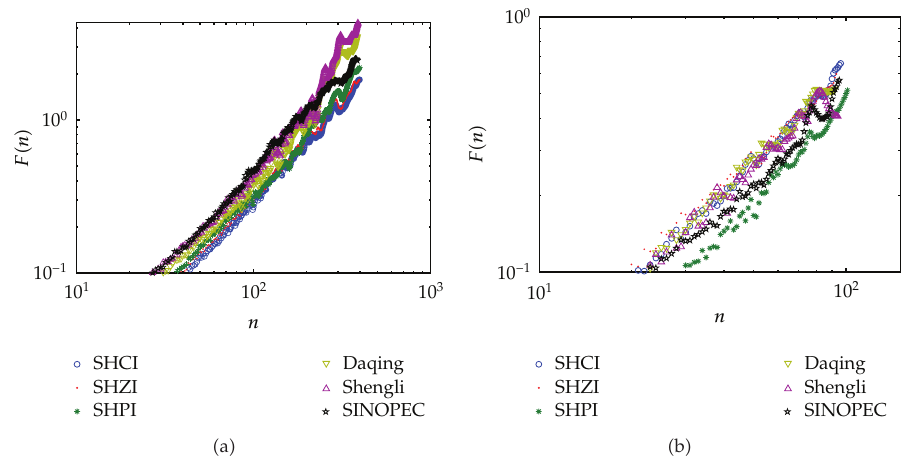
Figure 8: Detrended fluctuation analysis for the absolute returns of the actual data and the predictive data. (cid:3) a (cid:4) The plot of the absolute returns for the actual data from January 2003 to December 2009. (cid:3) b (cid:4) The plot of the absolute returns of the predictive data from January 2008 to December 2009.